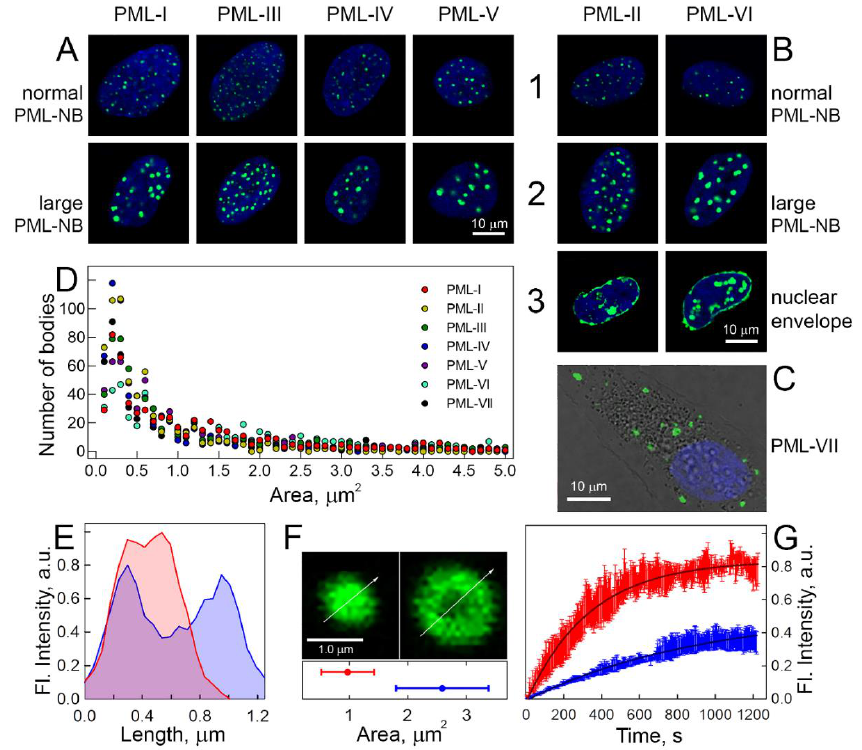
Figure 2. Localization, shape, size distribution, and dynamic properties of PML bodies visualized by various exogenous EGFP-PML isoforms in the presence of all endogenous forms of PML protein in U2OS cells. Nuclear localization of normal, small (area < 1.5 μ m 2 , row 1) and large (area > 1.75 μ m 2 , row 2) PML-bodies with exogenous PML isoforms I, III, IV, and V ( A ) and PML isoforms II and VI ( B ). Row 3 ( B ) — Migration of exogenous PML-II and PML-VI to the nuclear lamina. ( C ) cytoplasmic localization of PML bodies visualized by exogenous GFP-PML VII. ( D ) Distribution of different PML bodies by size. In all figures representing images of PML bodies, the scale bar is 10 μ m. The nuclei are colored with DAPI. ( E ) Radial distribution of EGFP fluorescence intensity for small spherical (<1.5 μ m 2 ; red) and large toroidal (>1.75 μ m 2 ; blue) PML-bodies. ( F ) Micrographs of small spherical and large toroidal PML-bodies. The red and blue lines at the bottom show the body sizes measured by the EGFP fluorescence recovery curves (FRAP) shown in ( G ). ( G ) FRAP curves after photobleaching of nuclear PML isoforms in PML bodies. Photoreduction curves of PML isoforms in small and large PML-bodies are shown in red and blue. The approximation of FRAP data within the mono- exponential approximation is shown by solid black curves. The initial fluorescence for all bodies before photobleaching is taken as